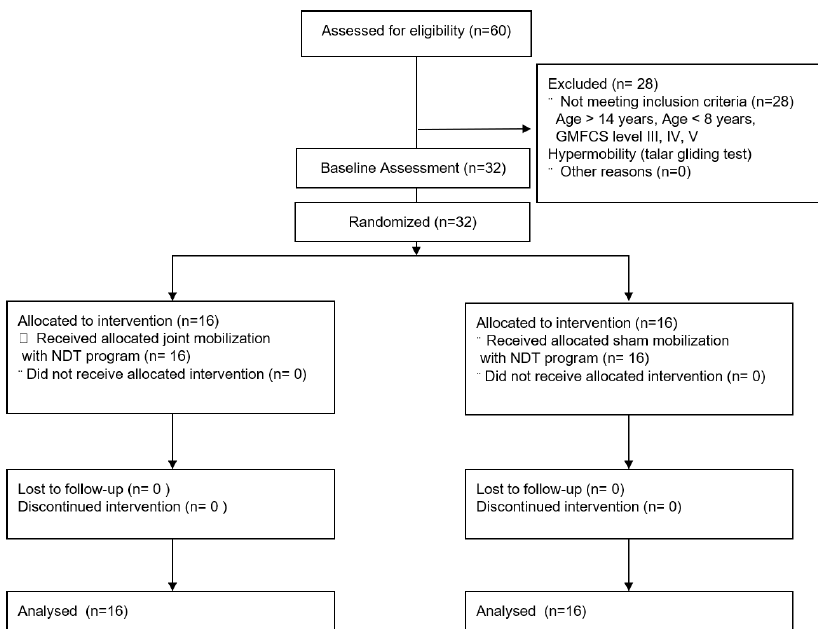
Figure 1. The flowchart of recruitment.